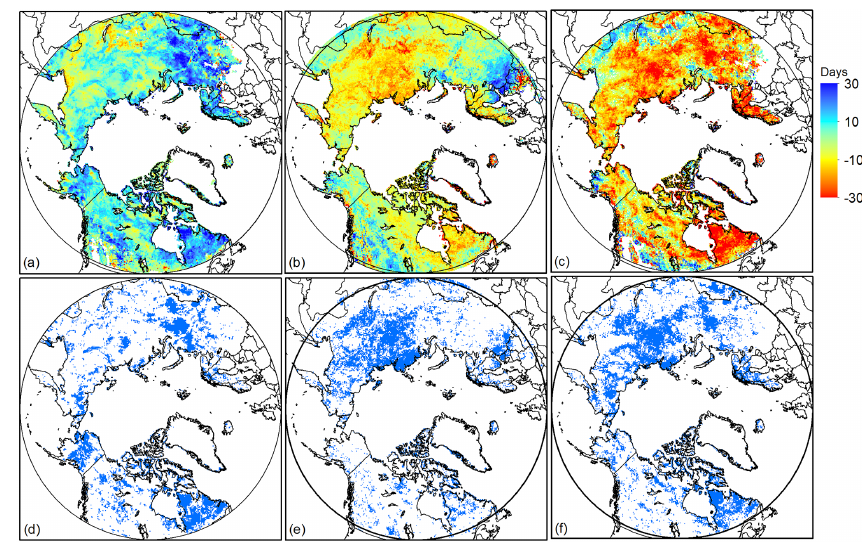
Figure 8. Mann-Kendall trends (days / 26 years) over the period 1988–2013 in (a) MSOD, (b) MMOD, (c) WPD. Grid cells with trends statistically significant at the 90% level are shown in (d) MSOD, (e) MMOD, and (f) WPD.